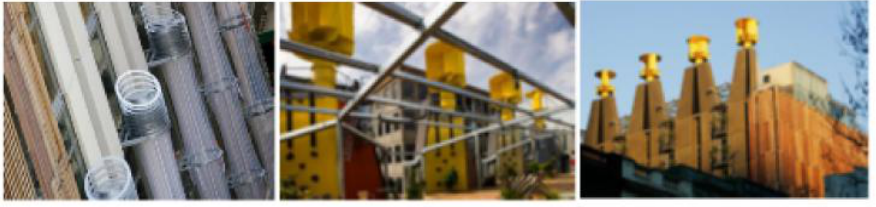
Fig. 5: CH building: right: northern view (air suction ducts) - middle: the roof structure – left: light-colored vents on the 2 southern façade (Meinhold, 2009; Pearce, 2014).